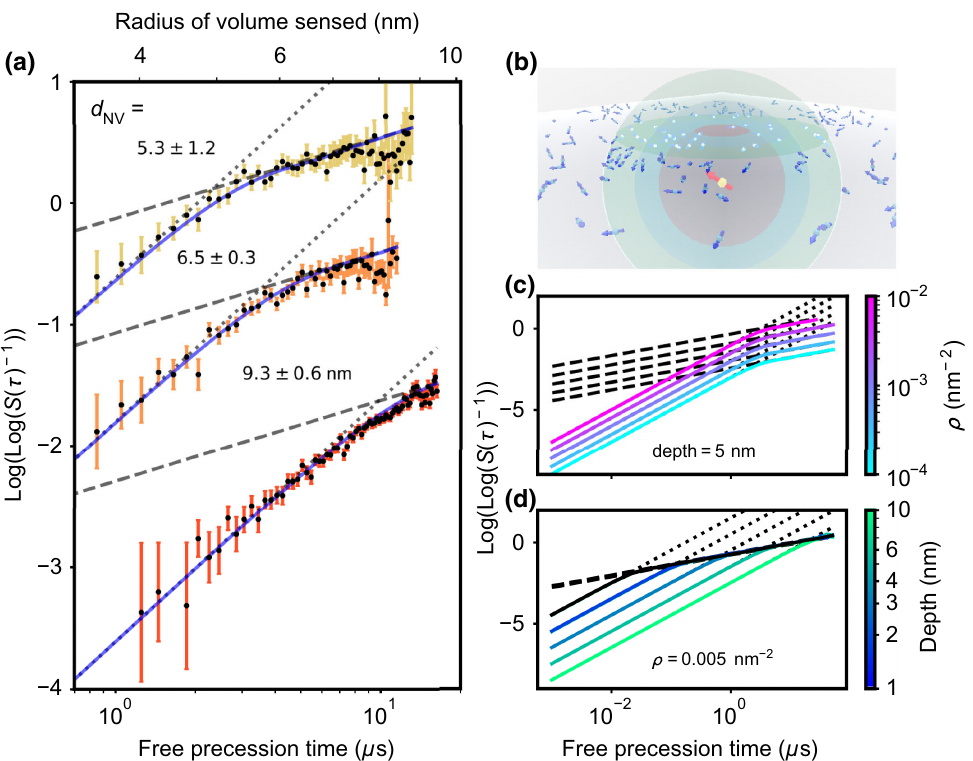
FIG. 3. Temporal transition of the stretching factor. (a) DEER echo signal from shallow NV centers in Sample 9 with three different depths extracted from the proton NMR signal. Error bars are the standard error of the mean due to photon shot noise. The blue line is a fit with the analytical result for configurational averaging (SI). The dashed line is n = 2 and the dotted line is n = 2 / 3. Curves are offset for clarity. (b) Diagram depicting the expanding strong dipolar coupling volume of the NV center as the duration of the echo sequence increases. The form of the signal detected by the NV center changes as the volume intersects with the 2D plane of the surface spins. (c) Simulations of the DEER echo signal detected from a 5-nm-deep NV center near a surface with a logarithmically spaced density of 10 − 4 nm − 2 (blue) to 10 − 2 nm − 2 (purple) where surface spins undergo configurational averaging. The dashed lines correspond to n = 2 and the dotted lines correspond to n = 2 / 3. (d) Simulation of the DEER echo signal detected from NV centers with log-spaced depths from 1 nm (blue) to 10 nm (green) with configurational averaging of the surface spins. The density of simulated surface spins is 0.005 nm − 2 . The solid black line is the analytic solution for a 1-nm-deep NV center